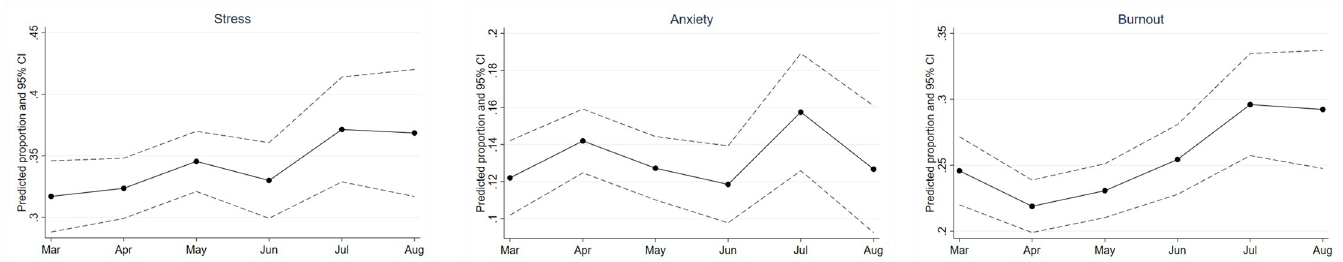
Fig 2. (a)-(c). Proportion of healthcare workers reporting stress, anxiety and job burnout. (a). Proportion of healthcare workers reporting stress between March-August 2021. (b). Proportion of healthcare workers reporting anxiety between March-August 2021. (c). Proportion of healthcare workers reporting job burnout